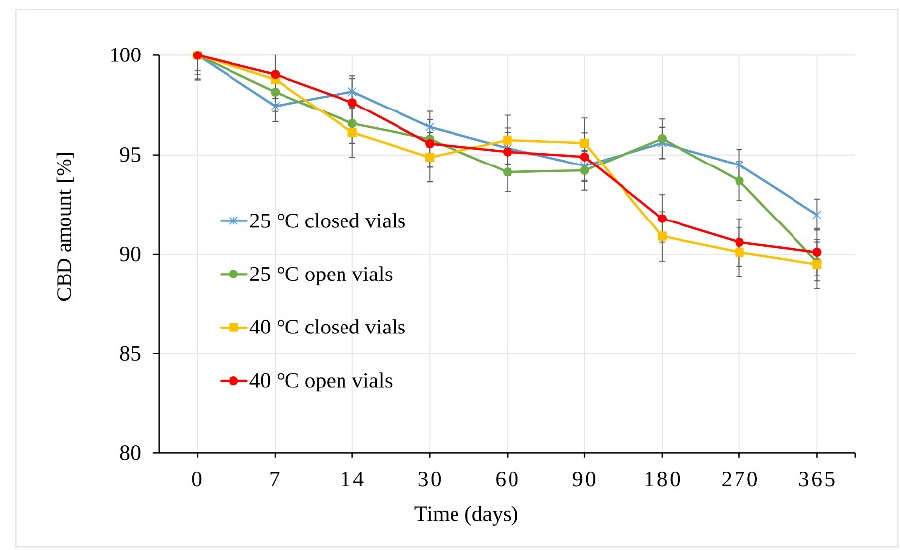
Figure 3. Stability of the CBD powder samples expressed as the amount of CBD over time measured by LC-UV (225 nm).